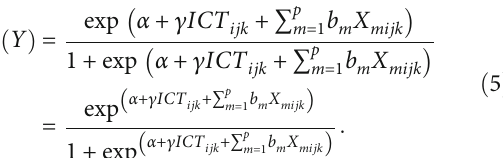
Free food/maize distribution, food/cash-for-work program, inputs-for-work program, targeted nutrition program, and direct cash transfer from